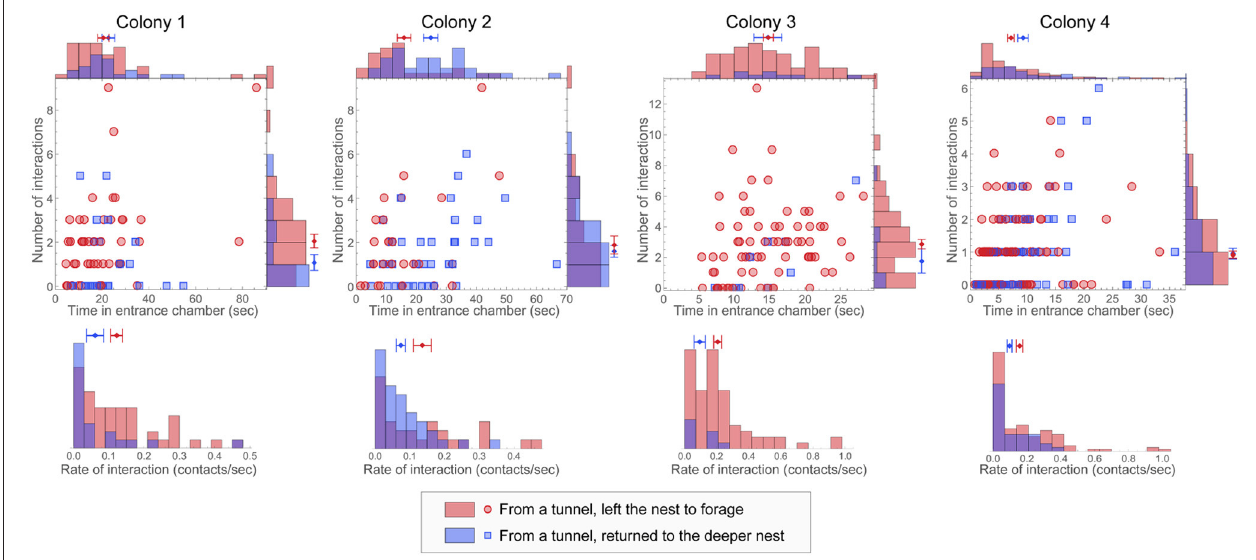
FIGURE 3 | Number of interactions, time in the entrance chamber, and rate of interaction of potential foragers. For each of the observations of a colony (columns), plots show the number of interactions and time spent in the entrance chamber for potential foragers from a tunnel that left the nest to forage (red points) or returned to the deeper nest (blue points). Histograms show the corresponding distributions for number of interactions, time in the entrance chamber, and rate of interaction. The per-ant mean and standard error of the mean for each quantity are displayed on each